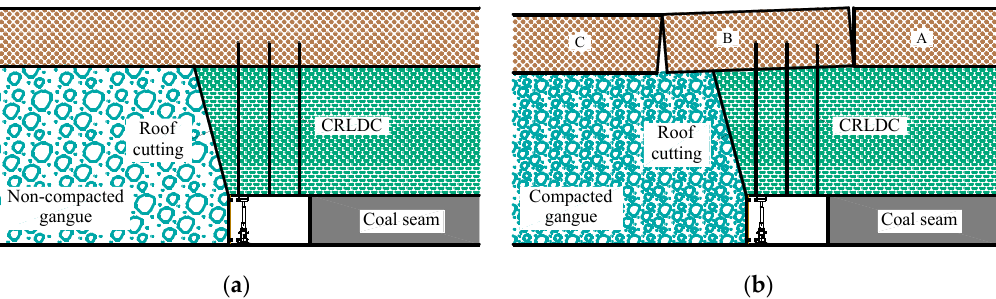
Figure 10. Roof structure and motion state when the roof-cutting height is sufficient. ( a ) Initial state; ( b ) Terminal state.